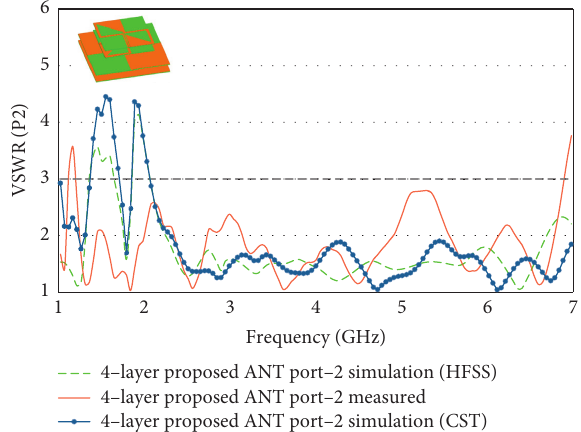
Figure 7: Measured and simulated VSWR (port-2) versus fre- quency of the proposed antenna.